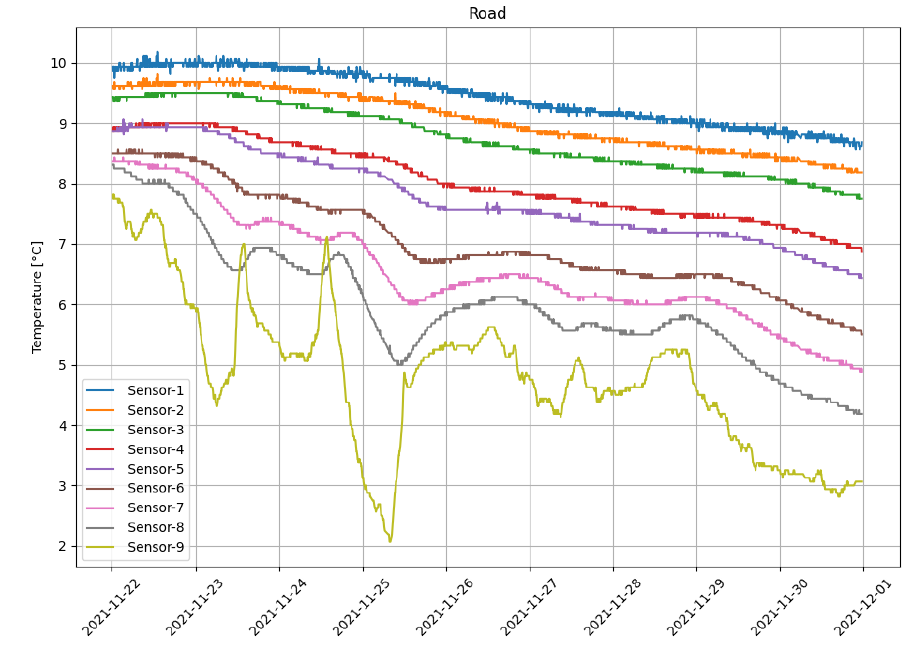
Figure 26. Vertical temperature measurements during one week.